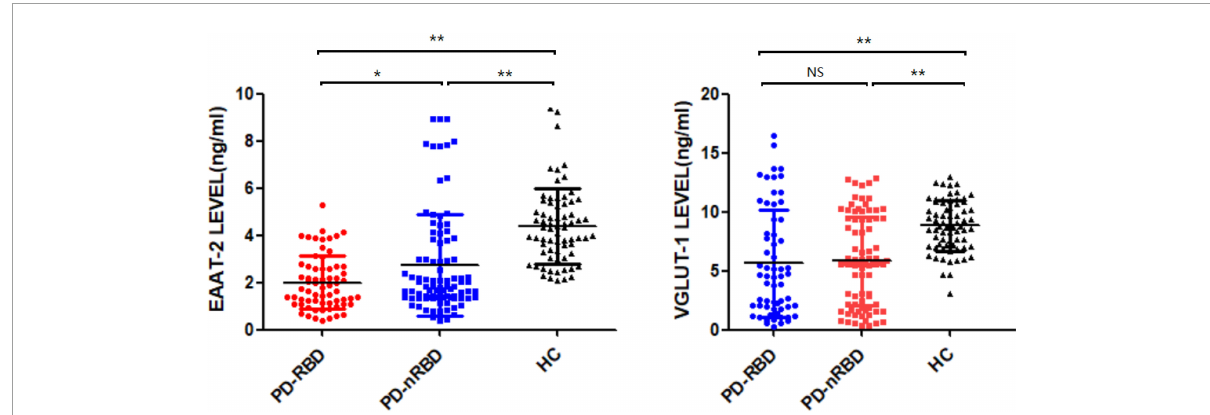
FIGURE3 Baseline plasma levels of neuronal exosomal VGLUT-1 and EAAT-2 in PD patients with and without RBD (PD-RBD and PD-nRBD) and healthy controls (HCs). The plasma levels of neuron-derived exosomal EAAT-2 and VGLUT-1 were significant decreased in PD patients compared with HCs. The plasma levels of neuron-derived exosomal EAAT-2 was significantly lower in PD with RBD group, * P < 0.05, ** P < 0.001.